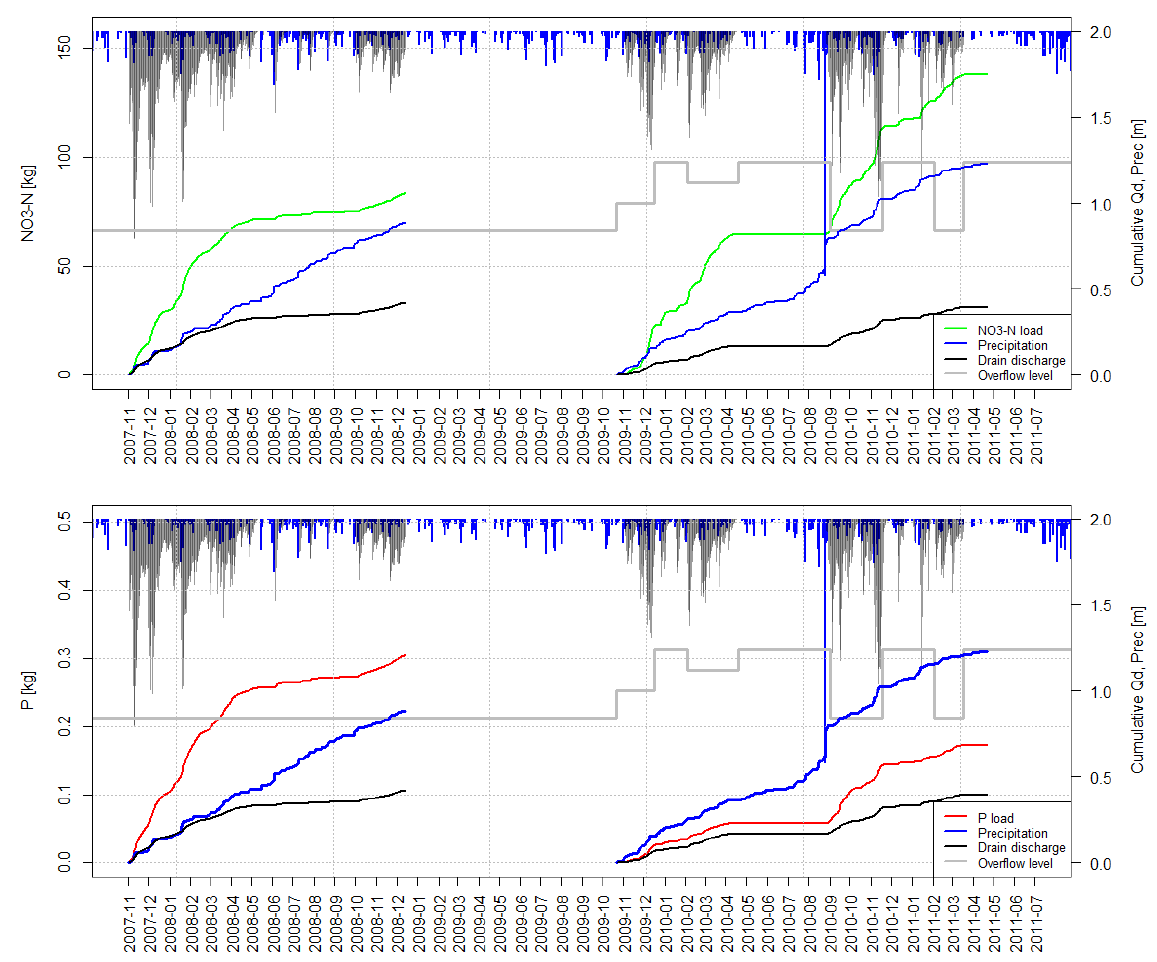
Figure 8. Cumulative precipitation, drain discharge, and drain NO 3 –N and P tot loads. Table 2. Comparison of NO 3 –N and P loads in the combined discharge of three drains between distinct periods. Precipitation and the ratios between loads and precipitation are also shown. The first three periods cover total years; the others compare shorter periods within the drainage